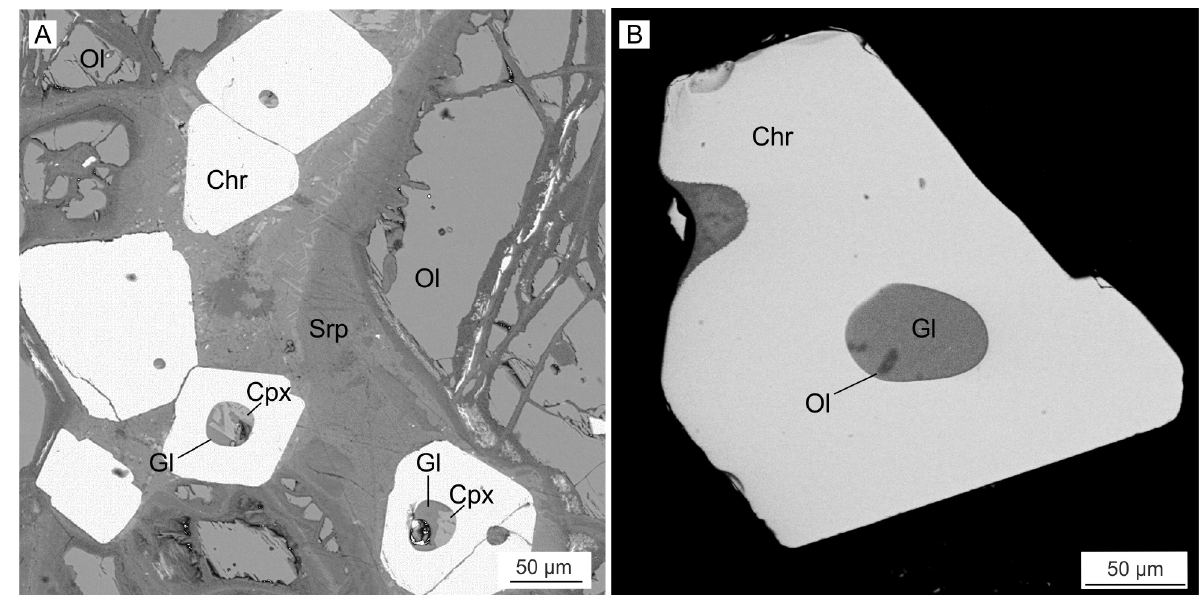
Figure 13. BSE photos of the chromite-hosted inclusions. ( A ) Grains with the melt inclusions, which used to be included in olivine and now are located in a serpentinized fracture; ( B ) heated up to 1250 °C and quenched melt inclusion.